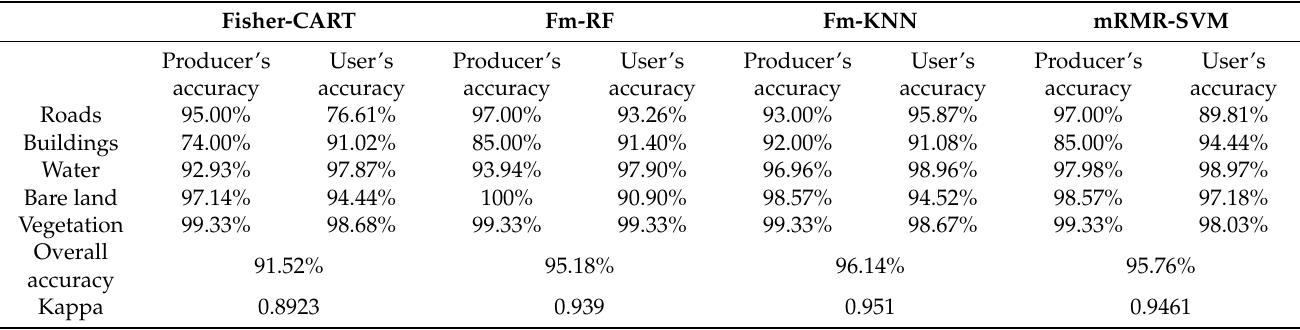
Table 4. Accuracy of ground cover